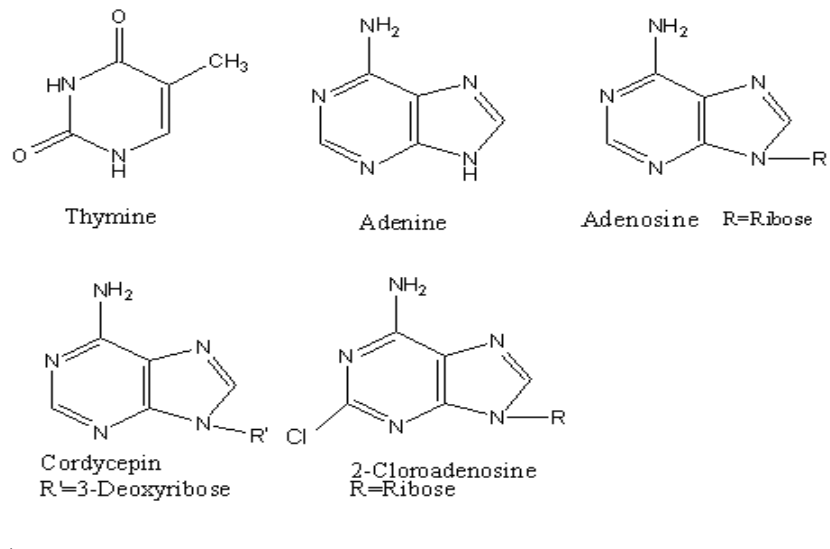
Figure 4. Structures of thymine, adenine, adenosine, cordycepin and